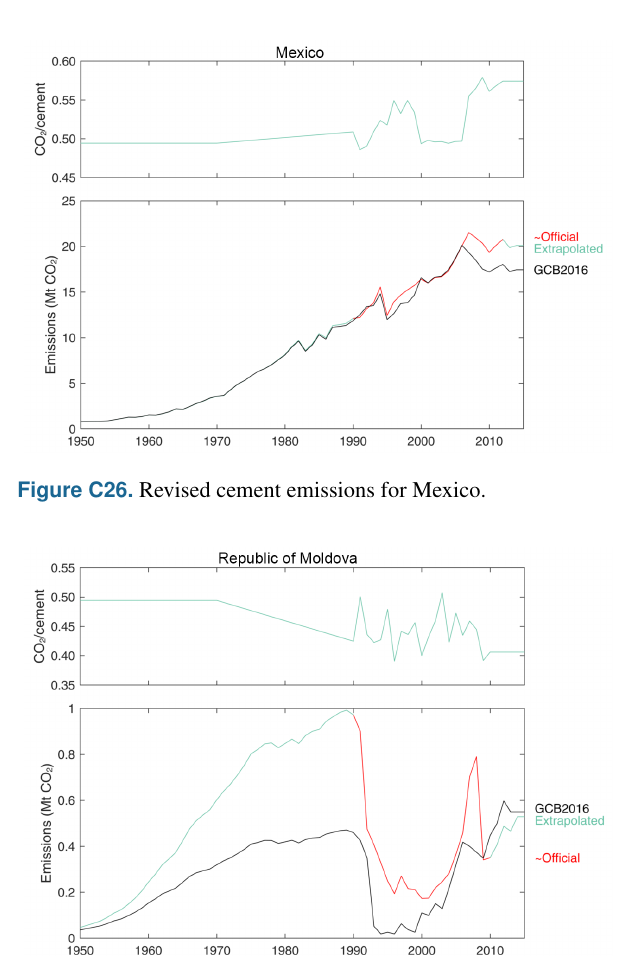
Figure C29. Revised cement emissions for